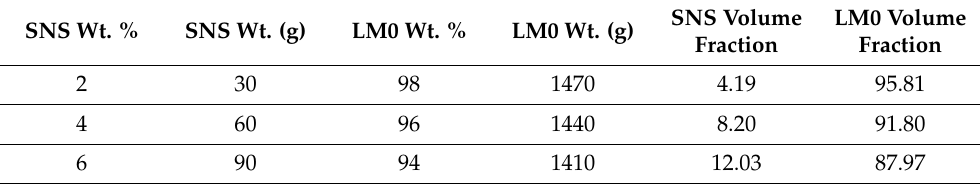
Table 2. Volume fractions of the SNS powder. SNS Wt.